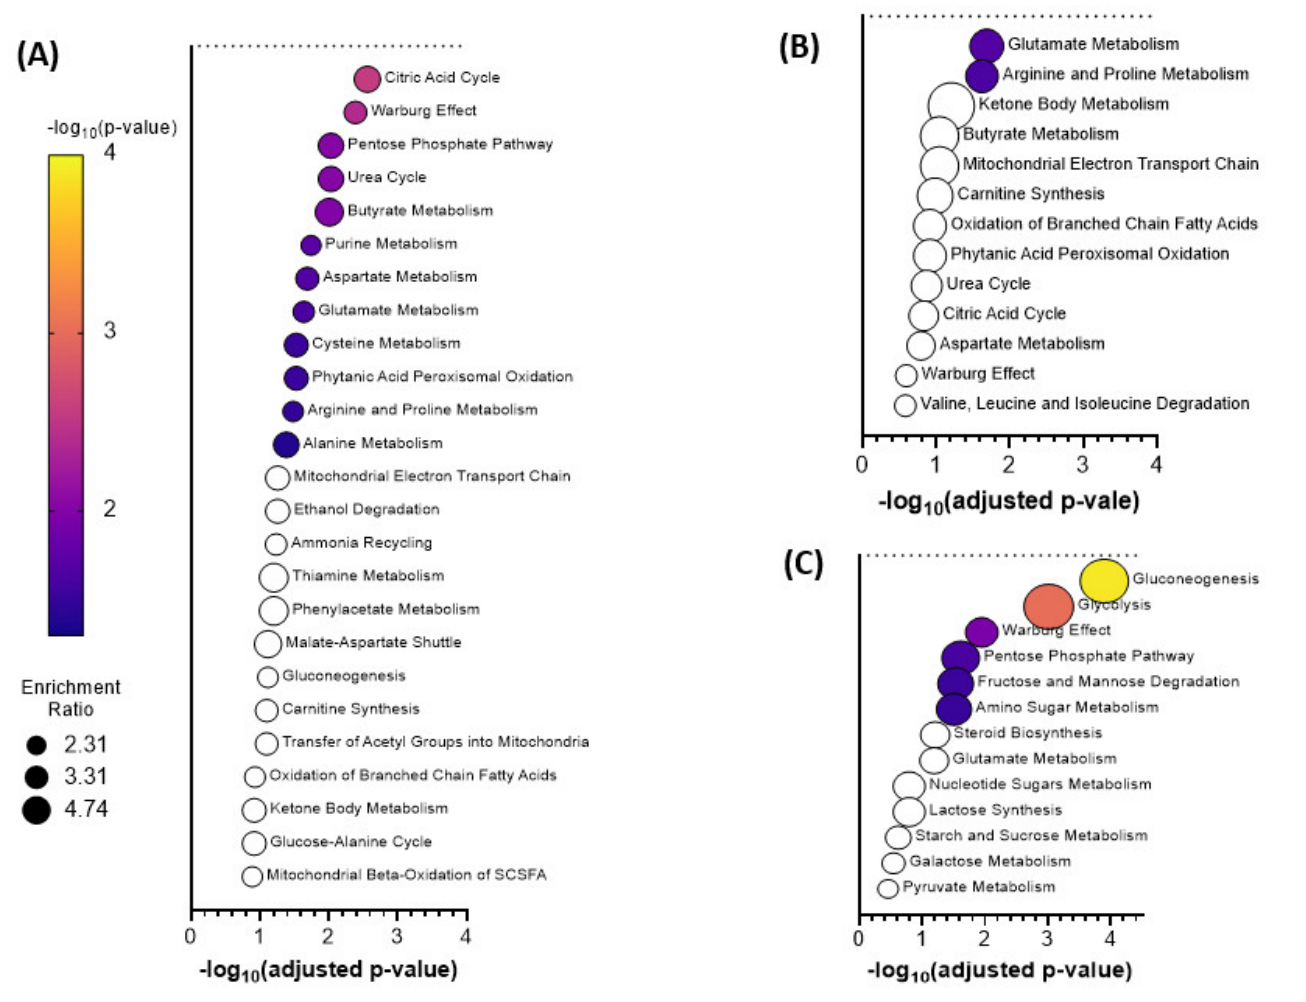
Figure 4. Significant pathways identified via the enrichment analysis of the identified significant metabolites and their associated ChemRICH chemical clusters during shedding and post shedding events of the ( A ) nasal wash, ( B ) oral swabs, and ( C ) rectal swab samples using MetaboAnalyst 5.0 (Enrichment Analysis Toolbox). Pathways annotated with white circles were enriched but found not to be significant.